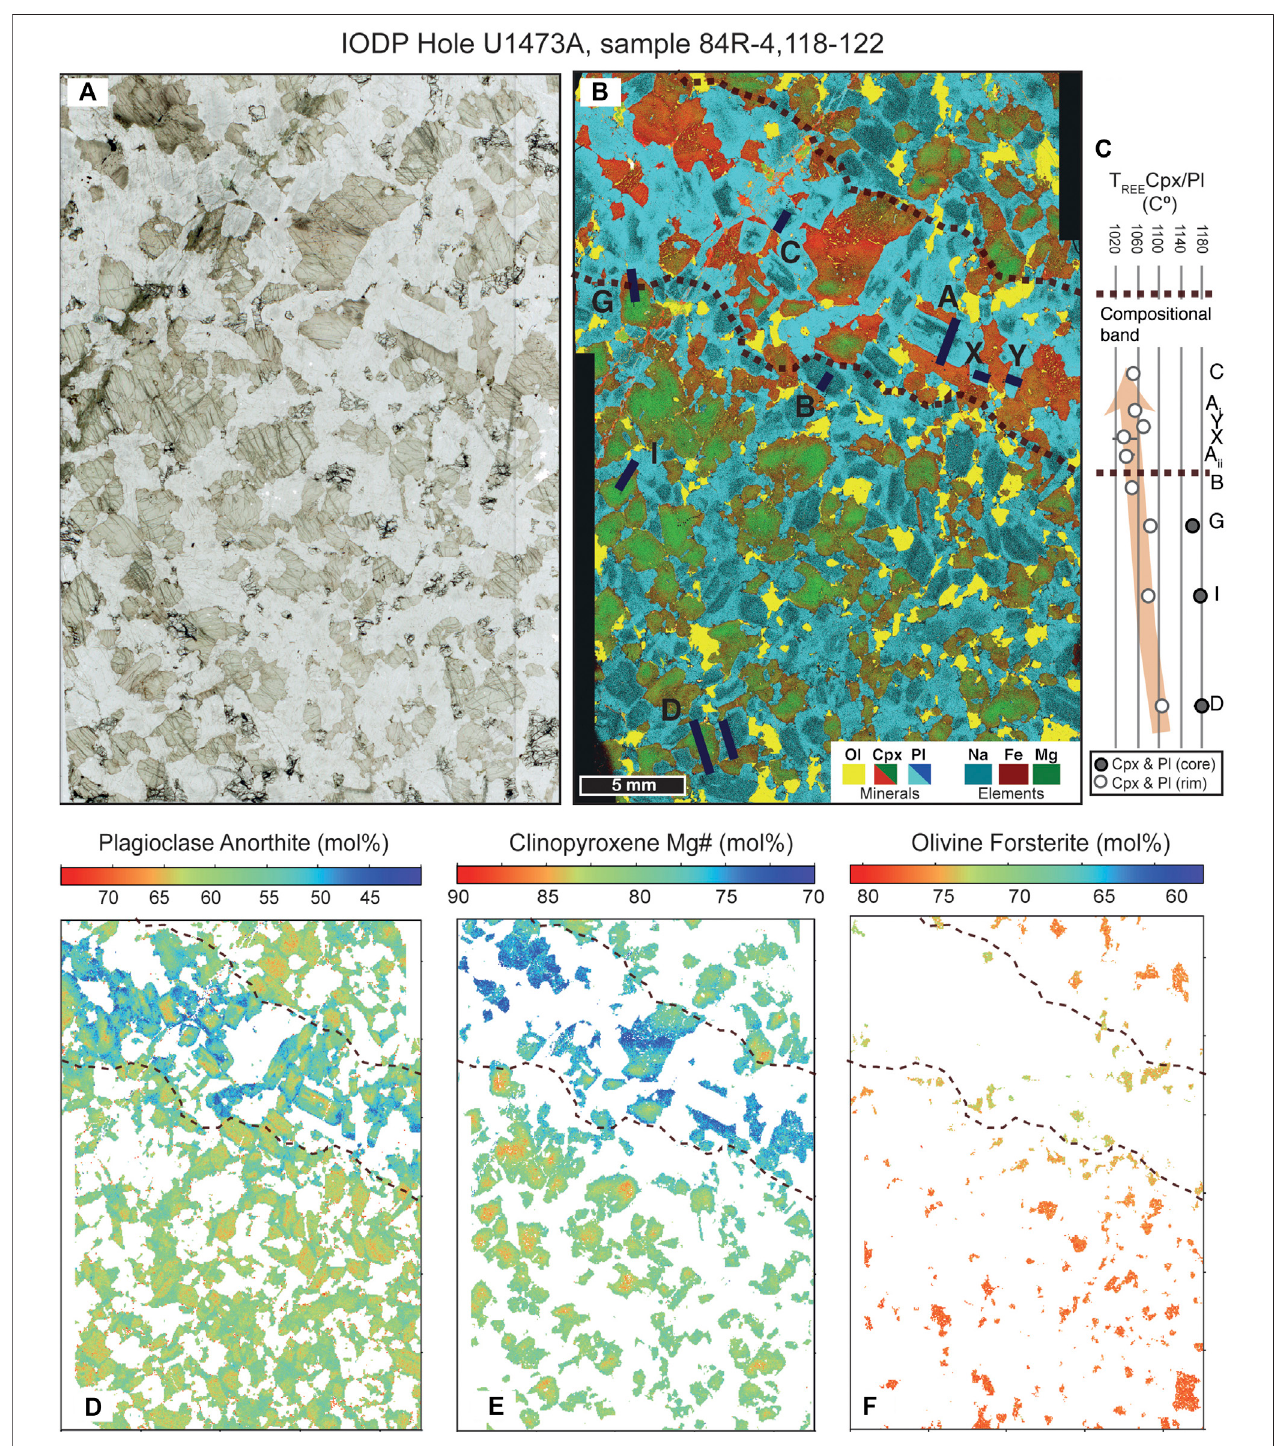
FIGURE 3 | (A) photomicrograph of sample U1473A-84R-4_118 – 112. The sample has a granular, equilibrated texture, with negligible crystal plastic deformation, andlackingpetrographicevidenceformineralreactions.ThecompositeMg-Fe-Na-Tielementmapin (B) howeverrevealsacompositionalbandwithinwhichplagioclase and clinopyroxenehave more evolved compositions. Corroded plagioclasecoresare preserved inthe band. (C) Variation ofthe Cpx-Pl equilibration temperatures using the Cpx-PlREE-Y geothermometer of Sun et al. (2017). Note that Cpx-Pl equilibration temperatures tend to decrease toward the compositional band. Core temperatures werenotcalculatedwithinthebanddue tothelackofclinopyroxenehavingcorecompositions. (D) Anorthite mapsinplagioclase (E) Fomapinolivineand (F) Mg#mapsinclinopyroxenecalculatedusingtheQuacksoftware.Blackdashedlinesin (B) , (D) , (E) and (F) delineatethecompositionalband.Alsoindicatedin (B) are the areas selected for the detailed trace element determination and the geochemical traverses (black lines).